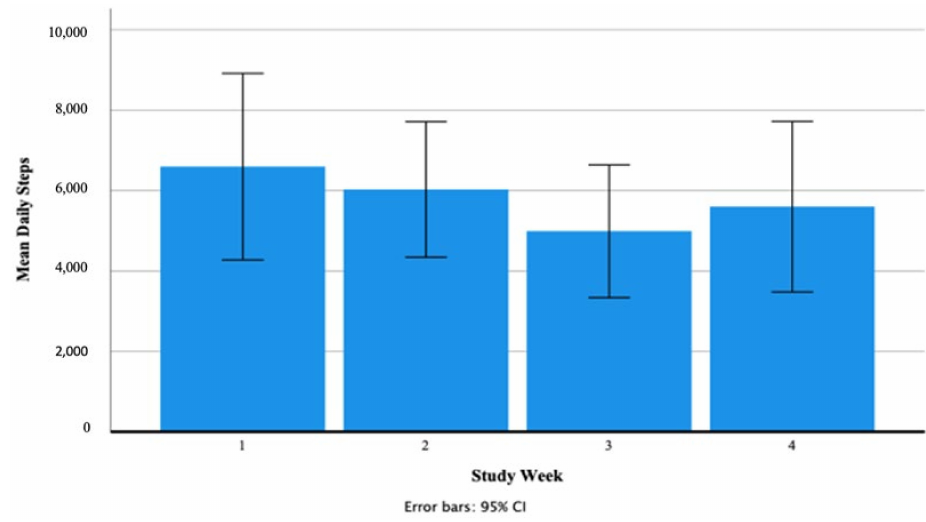
Figure 2. Participants’ mean daily steps as recorded via the Fitbit Charge 4 activity tracker.